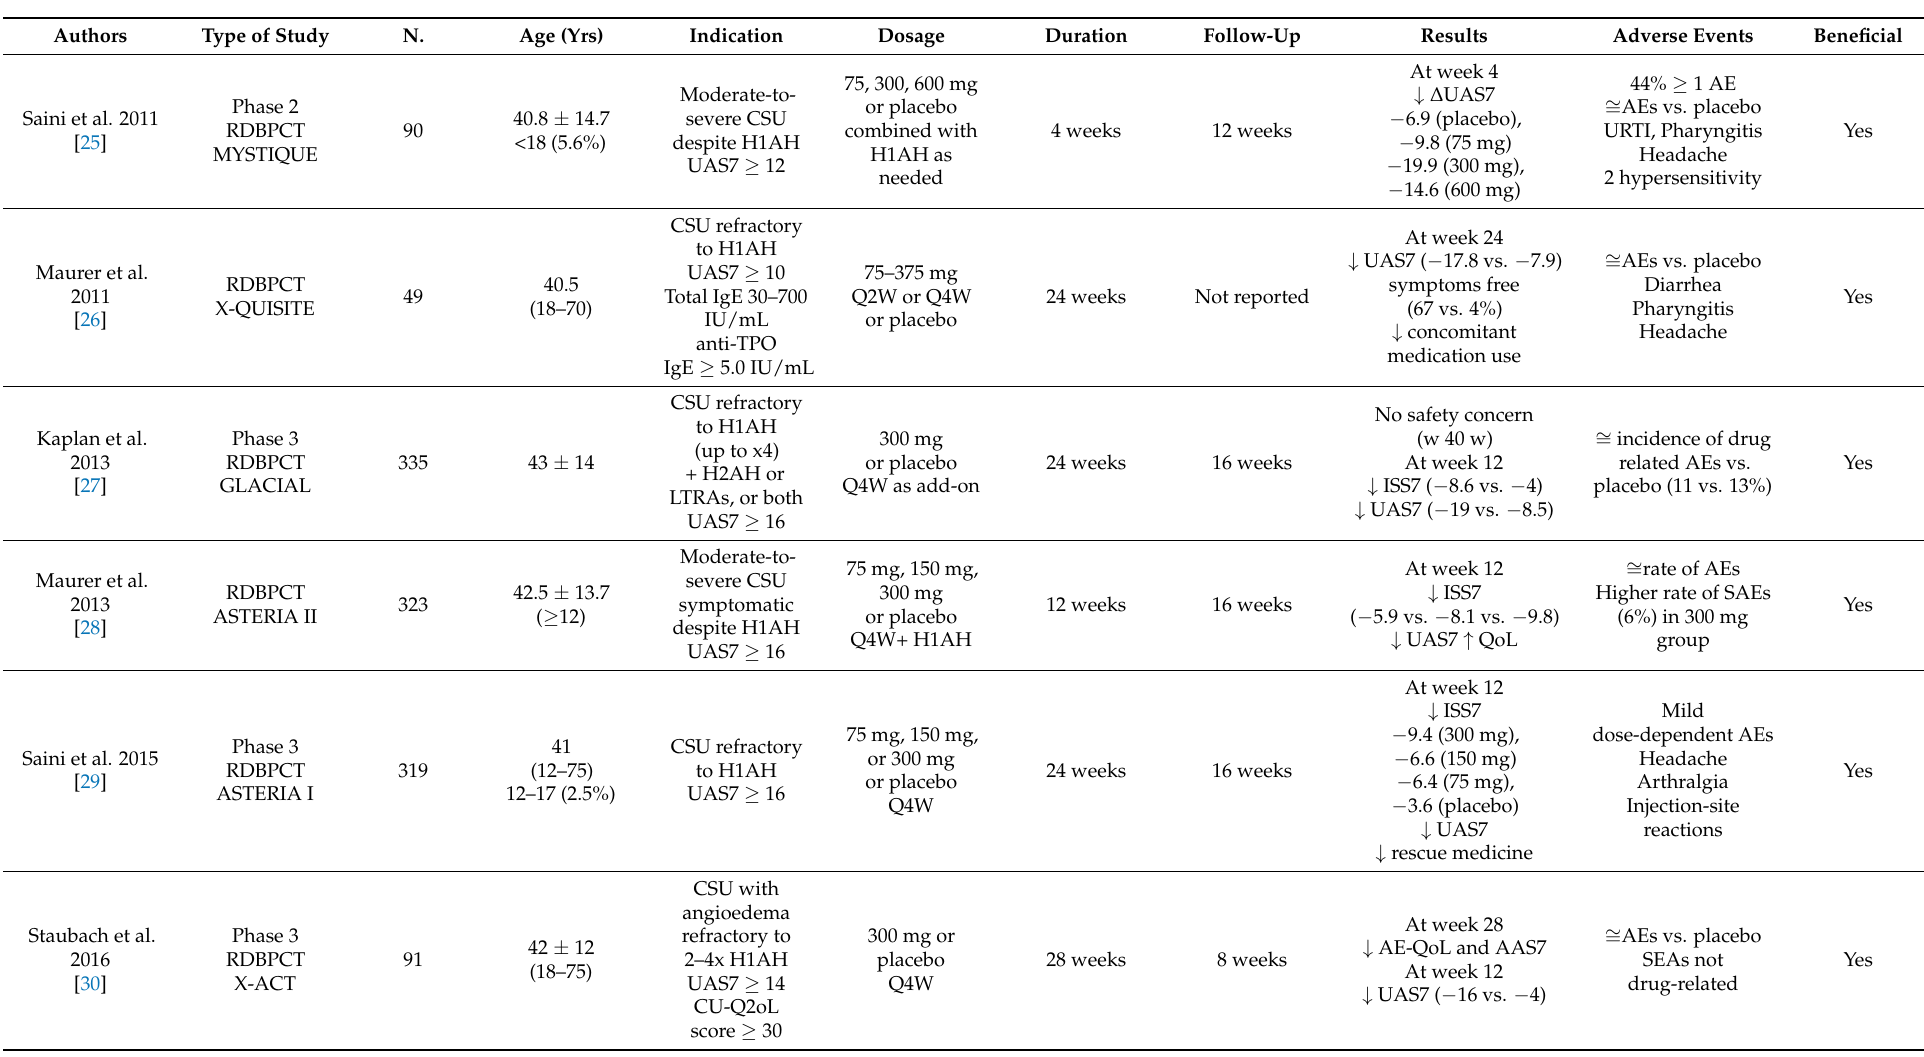
Table 1. List of the studies investigating omalizumab in treating